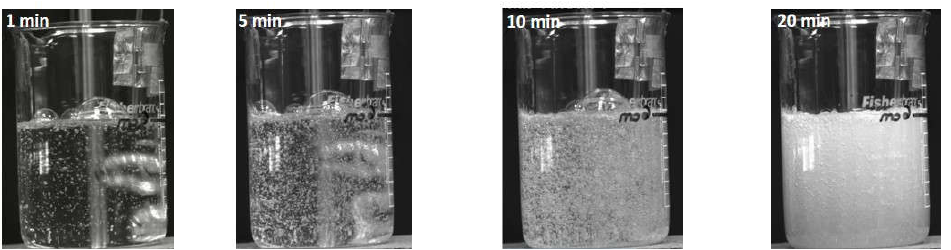
Figure 3. Snapshots of the undercooled Xylitol crystallization induced by air bubbling in a glass beaker at different times (air flow rate = 80 L/h; Starting Temperature T0 = 50 °C, undercooling degree ΔT = 45 °C).